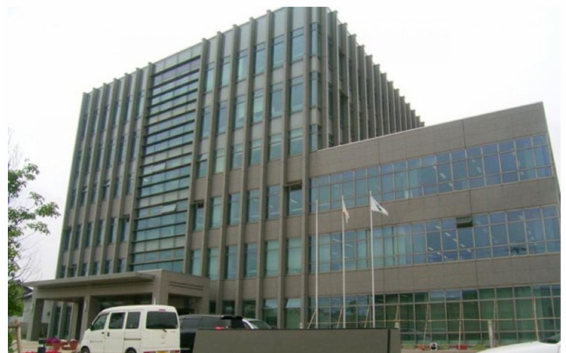
Figure 2. Tahara City Hall Building.